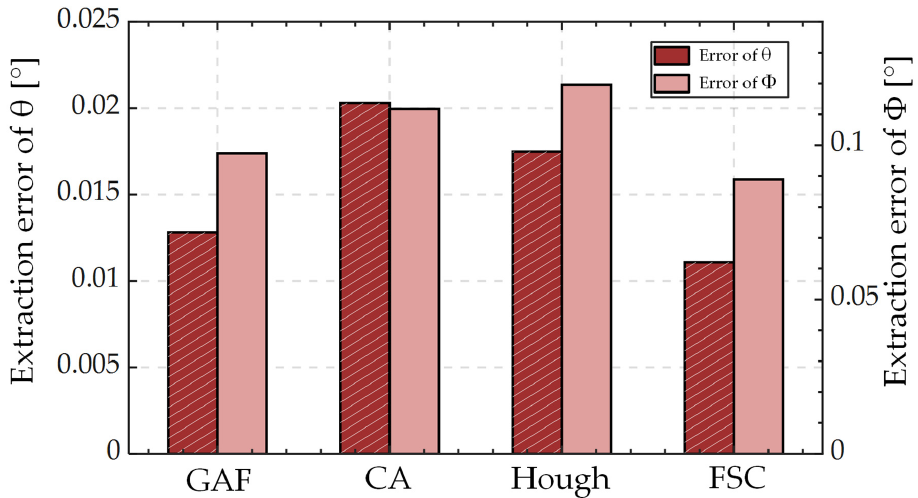
Figure 13. Mean prediction errors of different